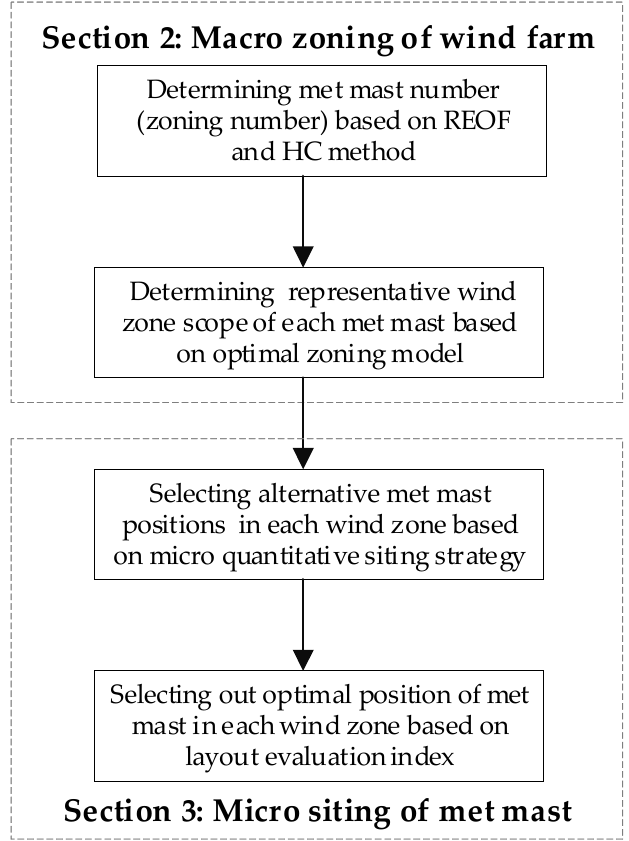
Figure 3. The research framework of this paper.